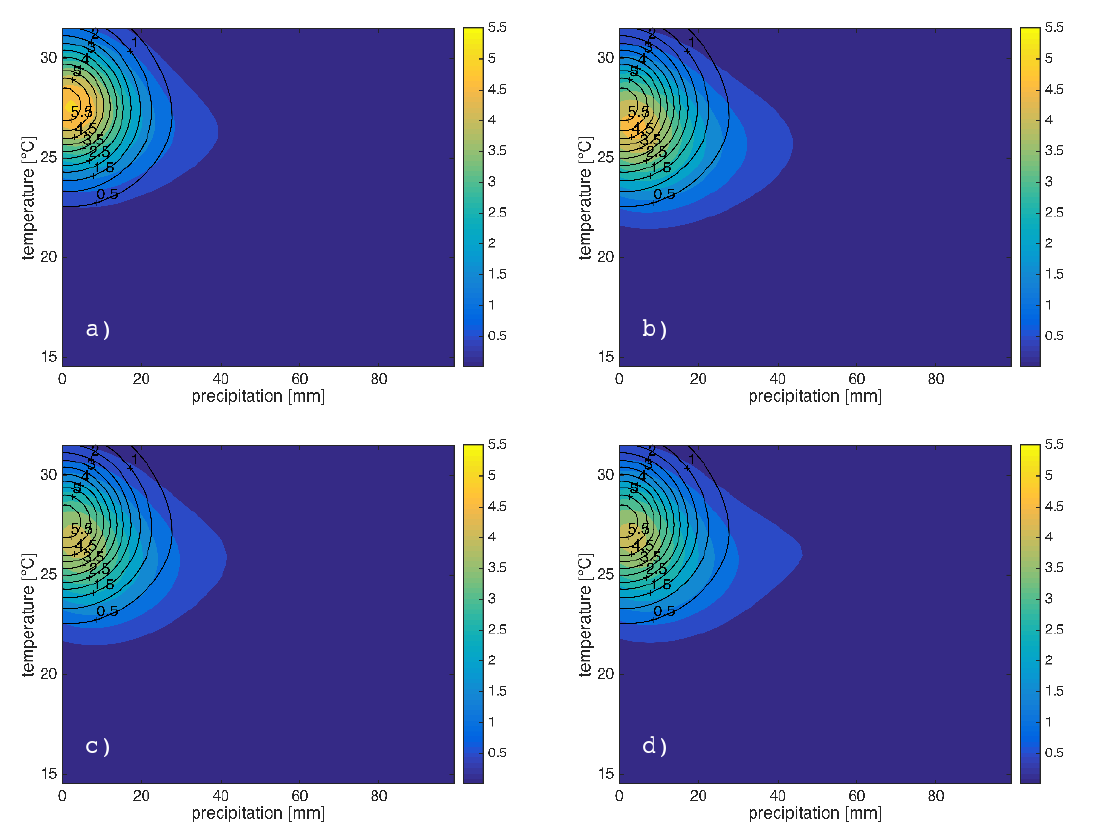
Figure 2. Bivariate probability density function (PDF) of P and T pairs in the data space at LAMU station for the ( a ) WRF-BLA, ( b ) WRF-GWA, ( c ) WRF-KLA, and ( d ) WRF-KWA simulations. WRF physics parameterization simulations are given in color, observations as black contour lines. Estimation is based on a nonparametric kernel density approach. Note that density values are multiplied by 10 3 due to relatively flat densities. Density values were derived at the points of a predefined grid, which is given by the min/max values as well as the 0.5 increment for P and T observations,